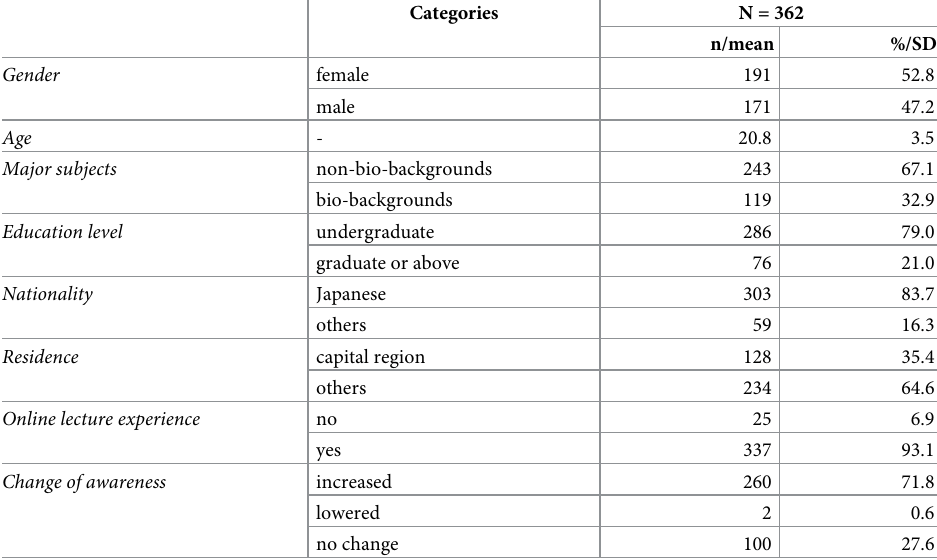
Table 1. The baseline information of participants.